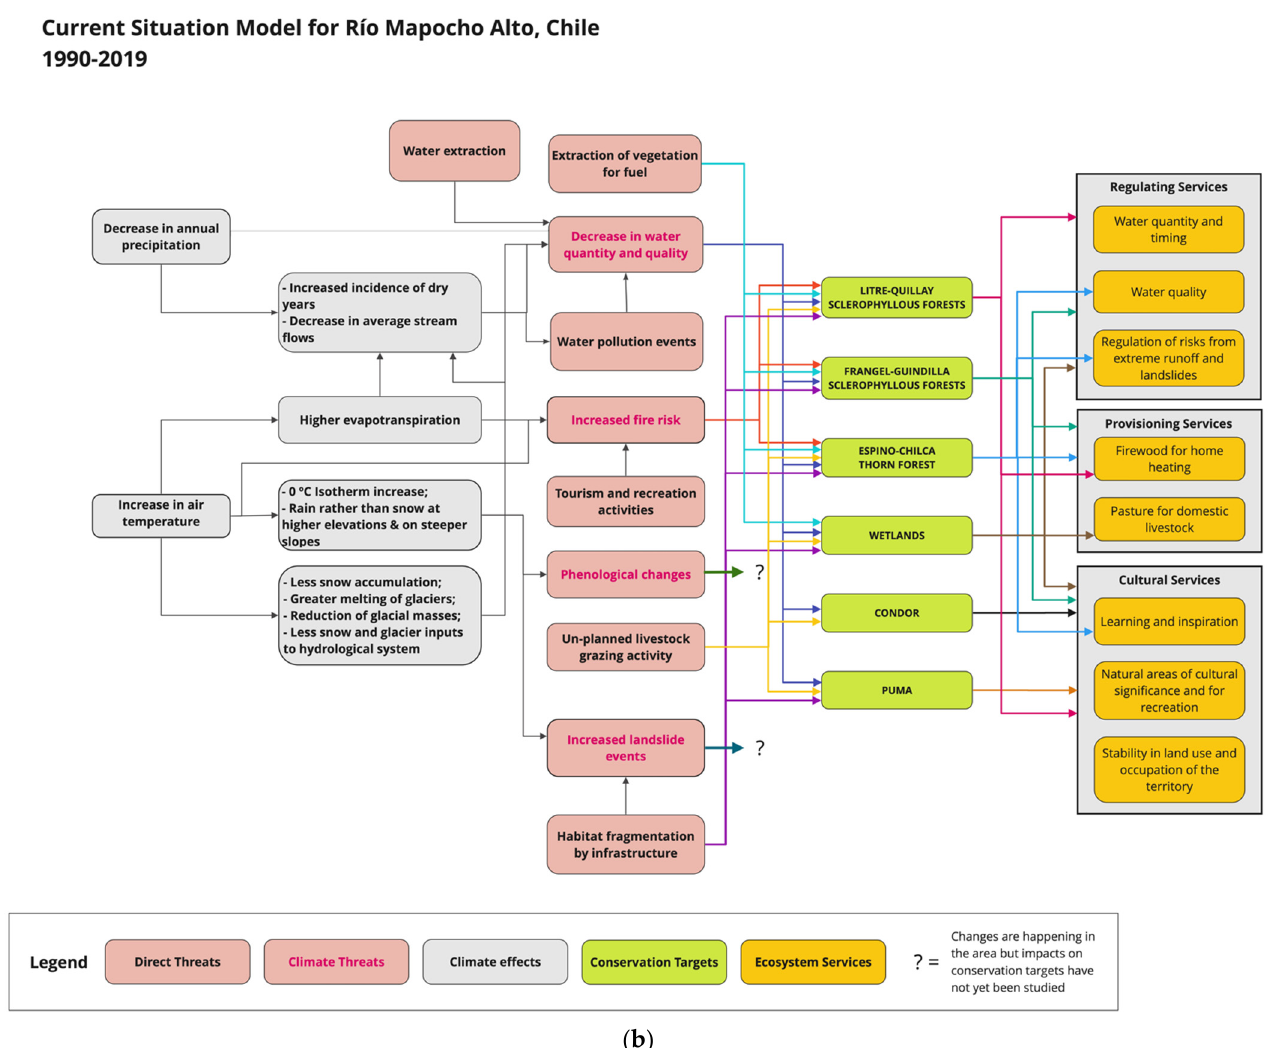
Figure 3. Excerpts from the current situation models for ( a ) the Tugai Nature Reserve in Central Asia (adapted with permission from ref. [25]), and ( b ) Río Mapocho Alto watershed in Chile.